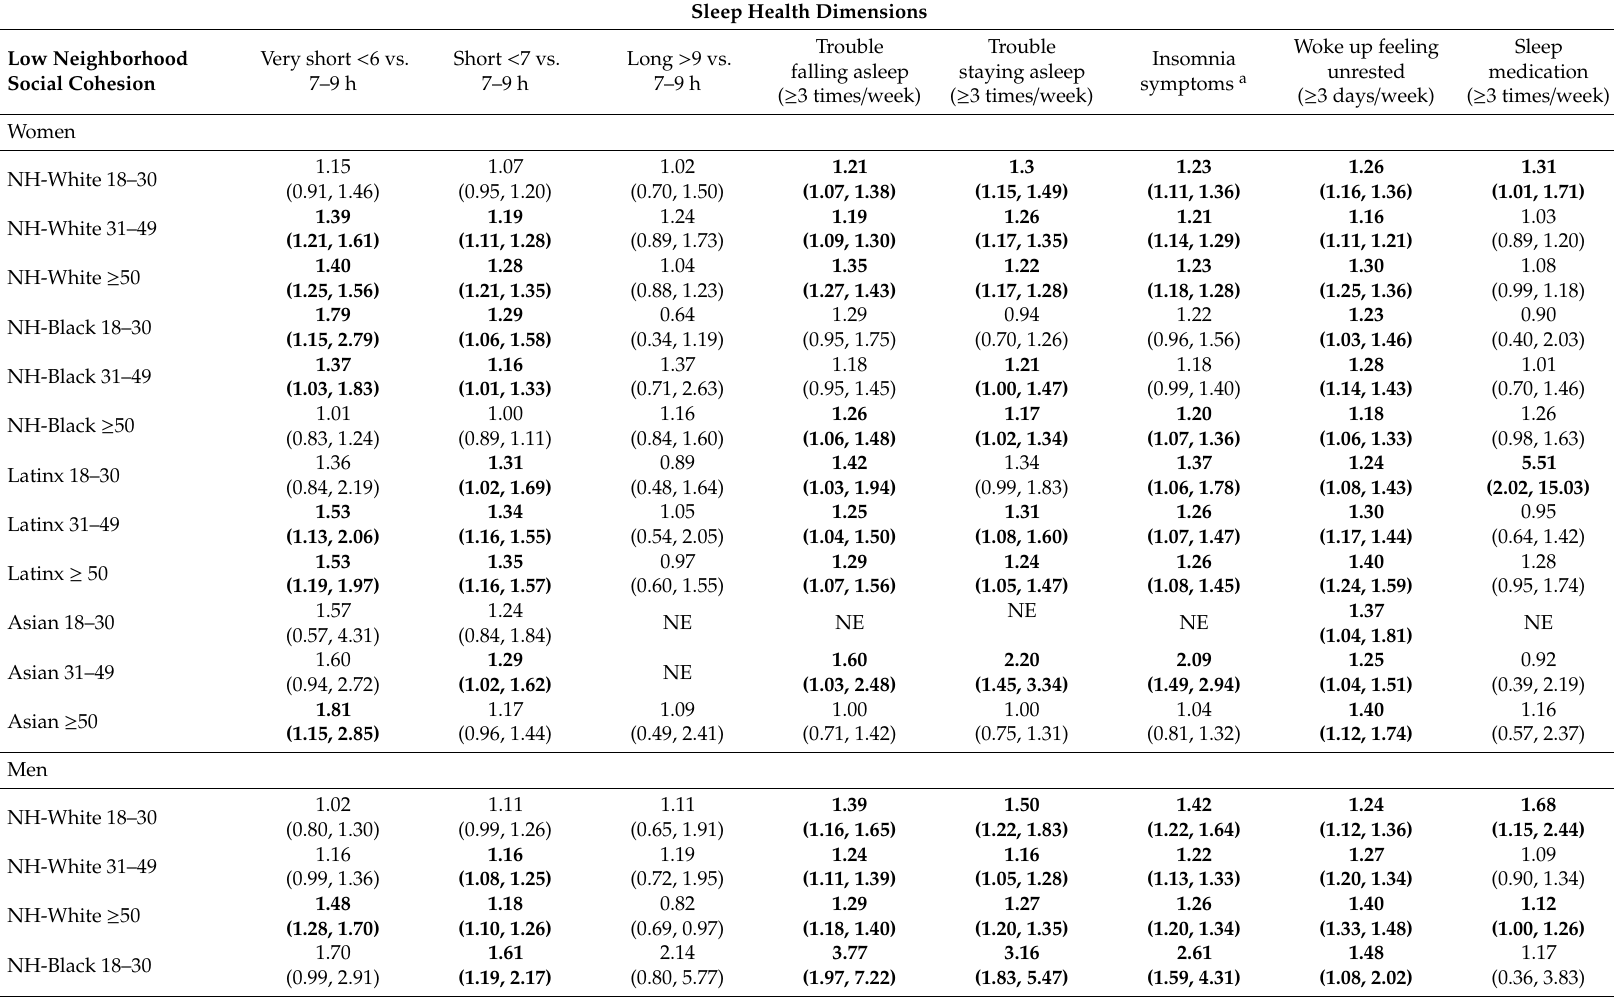
Table 2. Adjusted prevalence ratios of sleep health by low and medium compared to high neighborhood social cohesion among U.S. racial / ethnic adults by age and sex / gender, National Health Interview Survey, 2013–2018 (n =